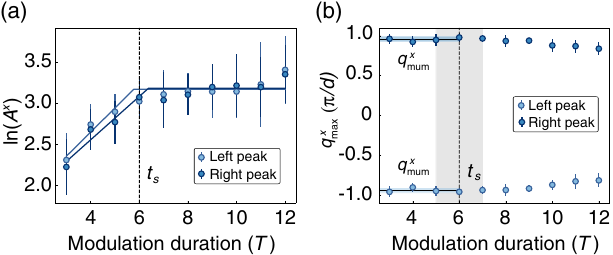
FIG. 3. Time-resolved growth of the most unstable mode for α ¼ 1 . 78 and ω = ð 2 π Þ ¼ 720 Hz. (a) Logarithmic plot of the peak amplitude A x as a function of modulation time. The solid lines are fits to the data to extract the end of the short-time regime t dashed line). (b) Position of the peak maximum q x function of modulation time. The most unstable mode q x defined as the weighted mean of all q x shown as the solid black line; the shaded blue bars denote its standard error of the weighted mean. The shaded gray area defines the range of hold times over which the transverse width Δ q y is averaged. Each data point is an average over ∼ 10 individual experimental realizations; error bars indicate the standard deviation. To minimize systematic deviations in the band-mapping images, we average ≲ 5 realizations for a modu- lation phase φ ¼ 0 and ≲ 5 with φ ¼ π (Fig. S1 of Supplemental Material